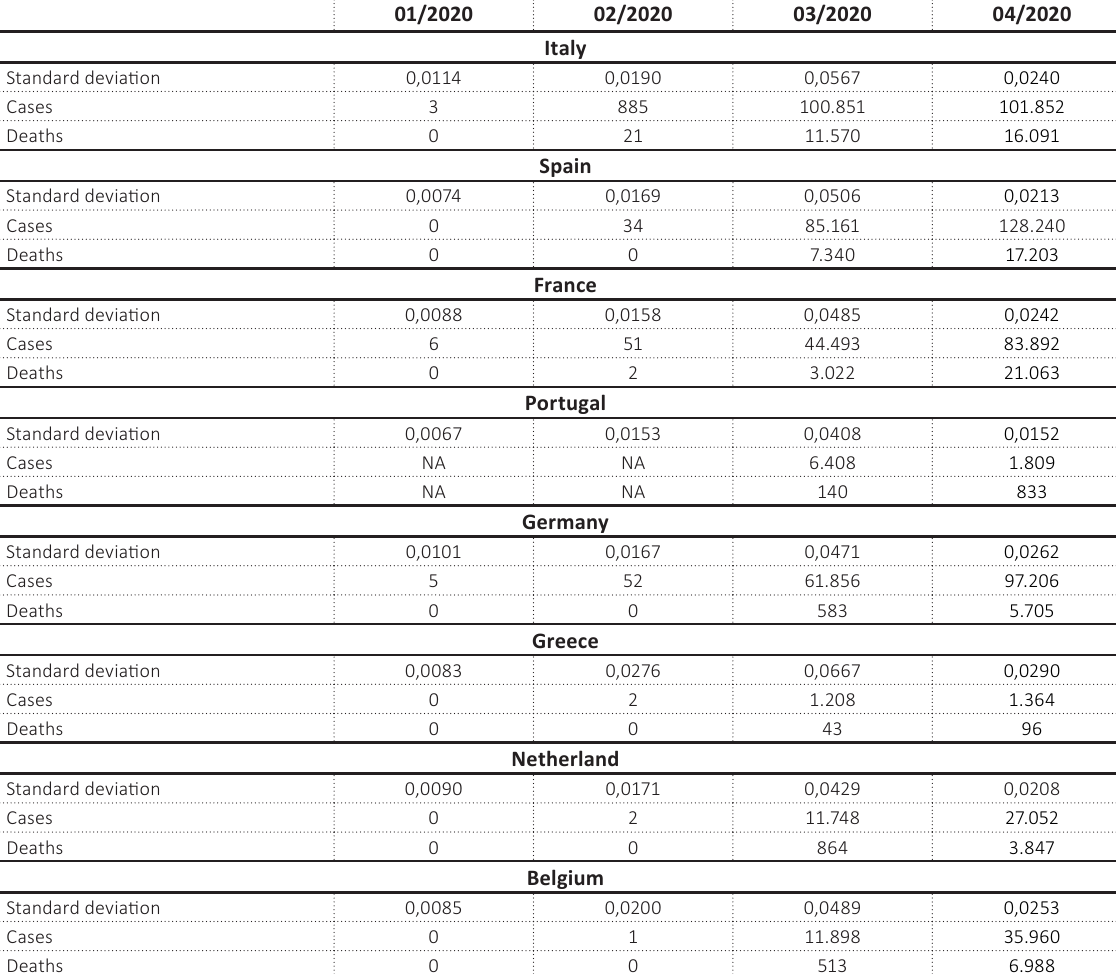
Table A2. Confirmed COVID-19 cases, deaths and market